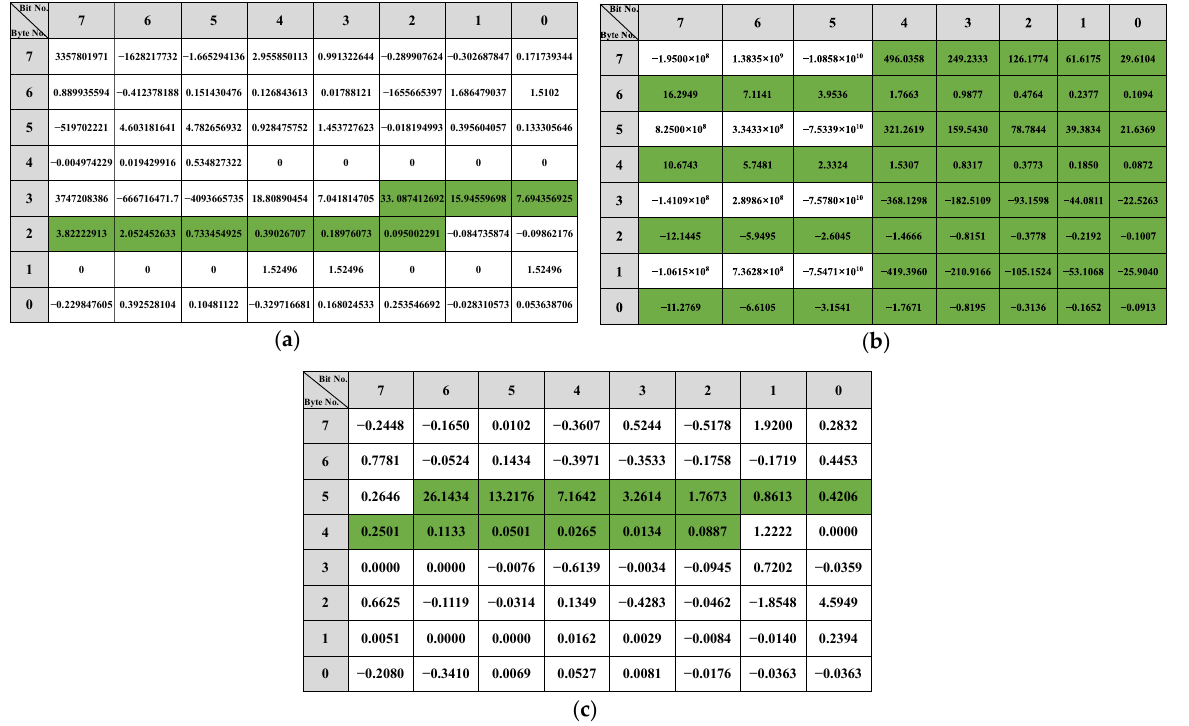
Figure 12. Speed-related messages reverse result: ( a ) ID 0x202 reverse result; ( b ) ID 0x215 reverse result; ( c ) ID 0x217 reverse result.